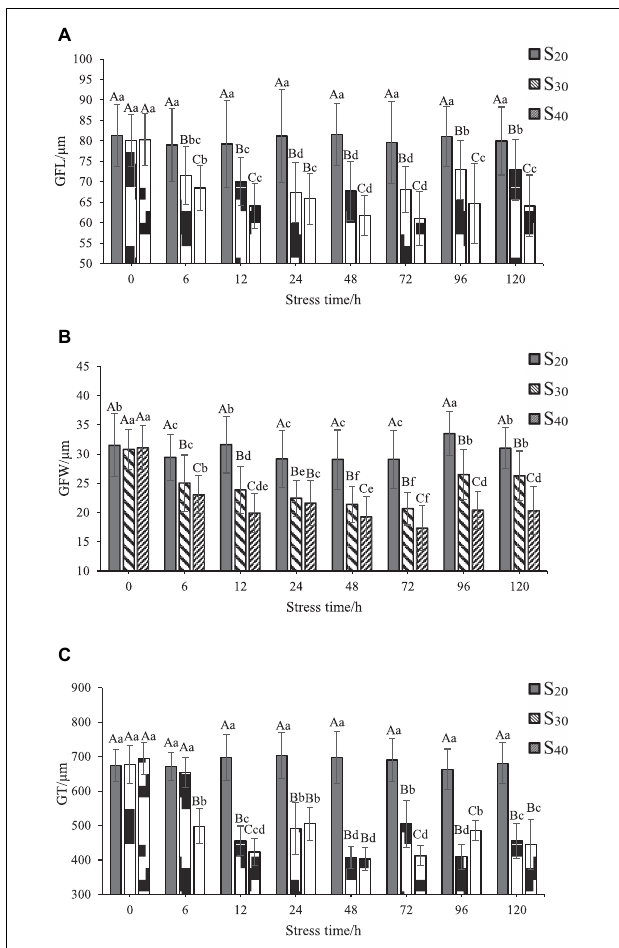
FIGURE 4 | Gill change of Sinonovacula constricta at different salinities and time points. (A) Gill filament length (GFL), (B) Gill filament width (GFW), and (C) Gill thickness (GT) at different salinities and time points. Different capital letters represent significant differences between groups treated with different salinity levels at the same time point ( P < 0.05), and different small letters represent significant differences between different time points for the same group ( P <